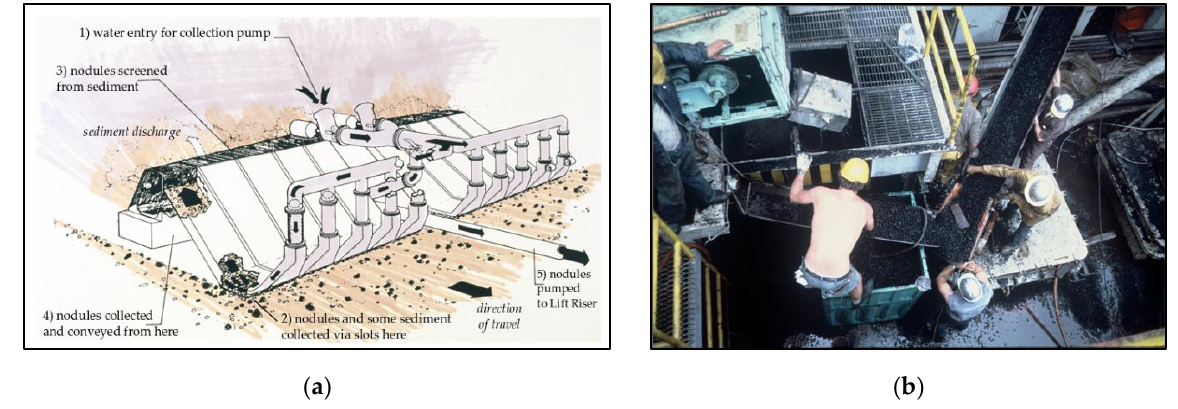
Figure 6. Polymetallic nodule pilot mining by Ocean Management Inc. of Seattle, United States in 1978. ( a ) Pilot nodule collector schematic; ( b ) reception of nodules at the surface vessel. Sourced and adapted from Brockett et al. [51].